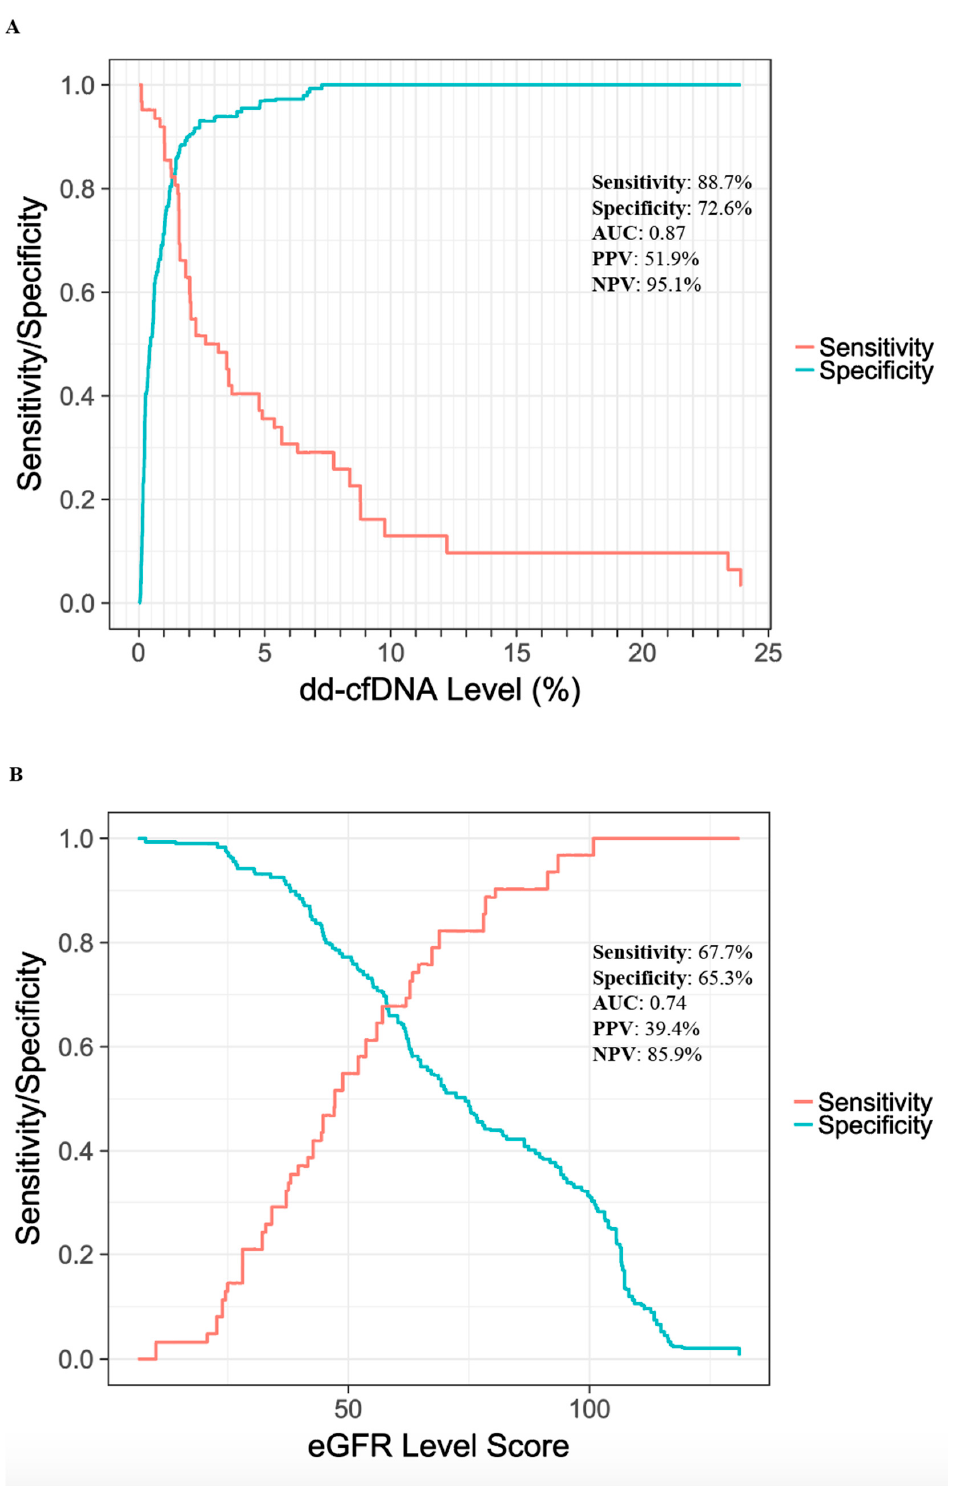
Figure 3. Predictive statistics for active rejection versus non-rejection. Sensitivity (red line) and specificity (blue line) are depicted over the observed range of dd-cfDNA levels ( A ) and eGFR scores ( B ). Reported sensitivity and specificity correspond to cutoffs of 1% for dd-cfDNA and a score of 60 for eGFR. PPV and NPV are based on a 25% AR prevalence. AUC, area under the curve; PPV, positive predictive value; NPV, negative predictive value.